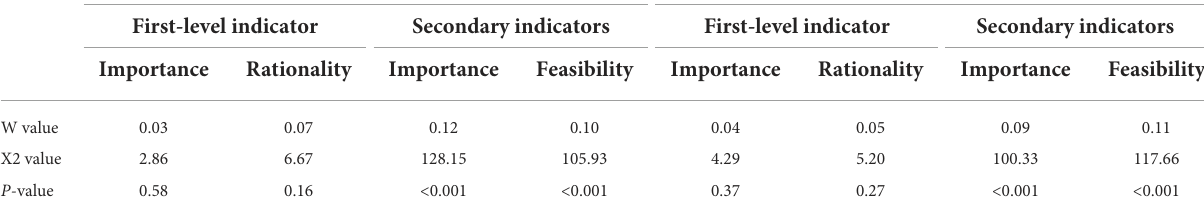
TABLE 3 Kendall coordination